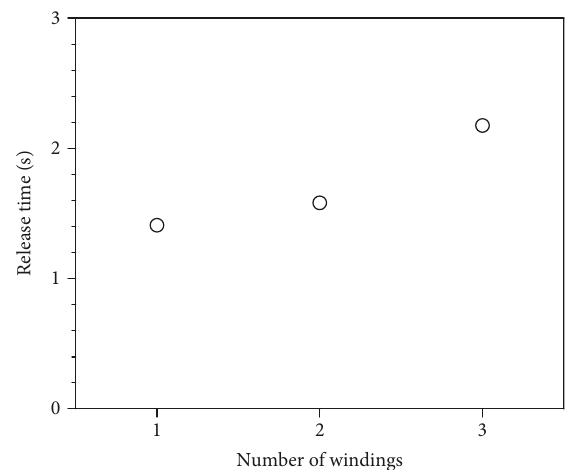
Figure 13: Release time of each solar panel as a function of quali fi cation temperature ranges at an input voltage of 8V.